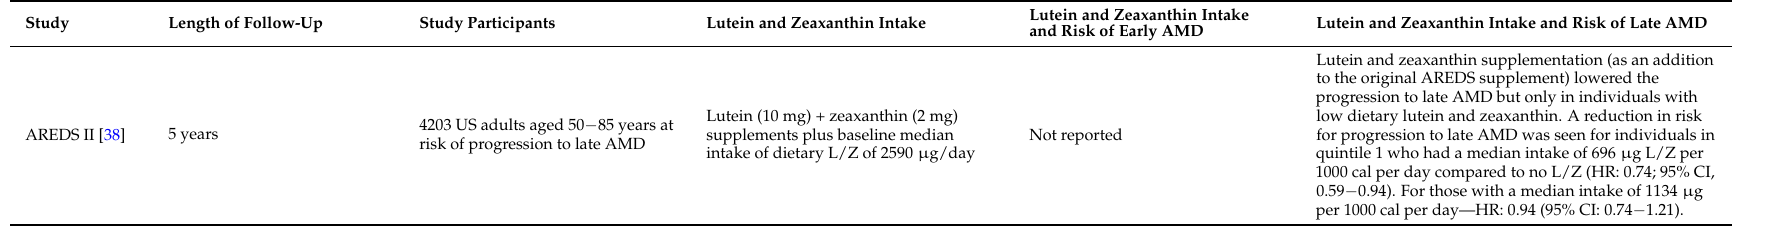
Table 3. Summary of randomised controlled trials regarding lutein and zeaxanthin intake and